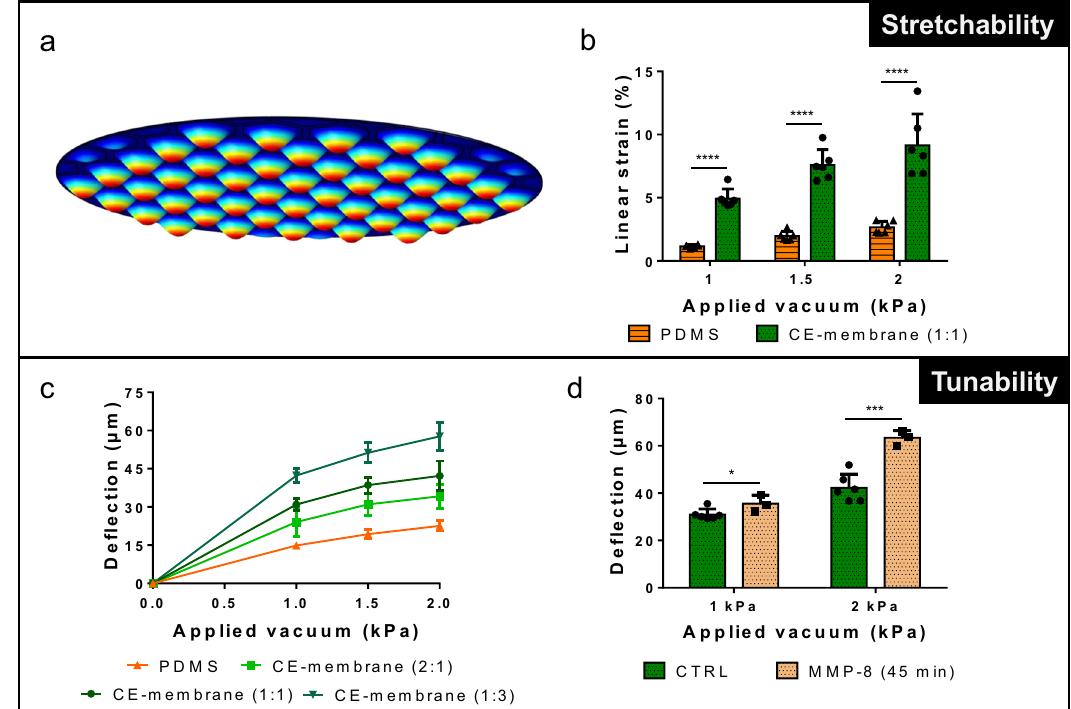
Fig. 3 Membrane fl exibility. a Numerical simulation of the de fl ection of the CE-membrane array. b Linear strain inside the CE membrane in function of the applied vacuum ( n = 6). A 10- µ m-thin PDMS membrane was taken as reference ( n = 6). c De fl ection of CE membranes of various compositions in function of an applied vacuum ( n = 6 for CE membrane (1:1) and CE membrane (2:1) and n = 4 for CE membrane (1:3)). A 10- µ m-thin PDMS membrane was taken as reference ( n = 6). d De fl ection of CE membrane exposed to MMP-8 in function of an applied vacuum ( n = 6 for CE membrane (1:1) (CTRL) and n = 3 for treated membranes (MMP-8 (45